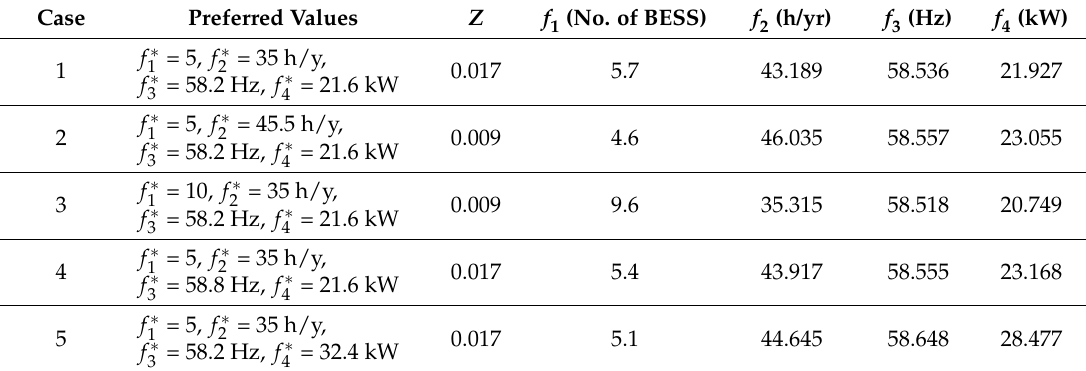
Table 8. Mean values of least upper bound Z and f (cid:96) for different f ∗ (cid:96)